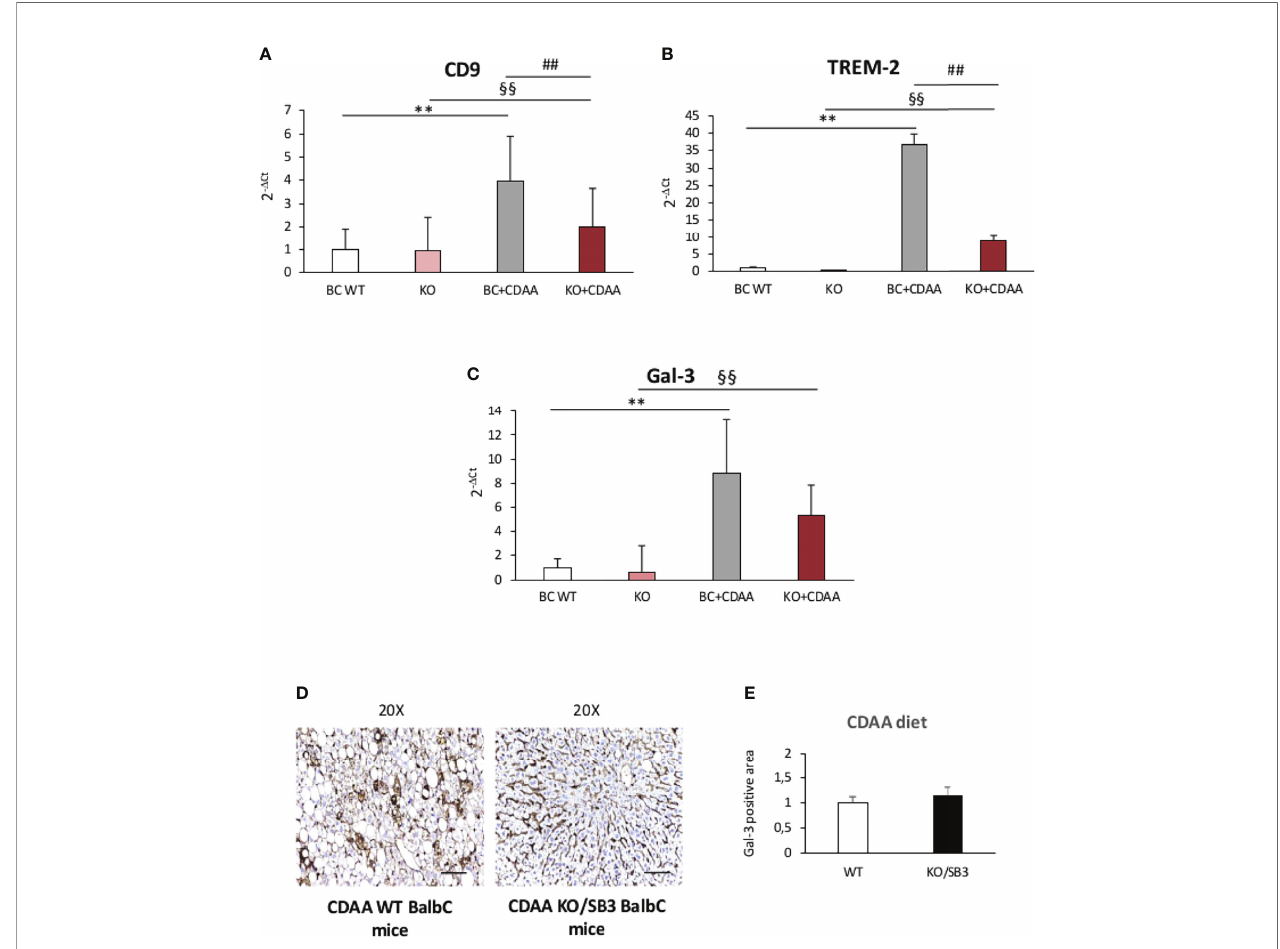
FIGURE 7 | (A – E) Quantitative real time PCR analysis of CD9, (A) TREM-2 (B) and Gal-3 (C) in control BalbC mice and knock out mice for SB3 fed on control diet (BC WT and KO) or CDAA diet for 12 weeks (BC+CDAA and KO+CDAA). **p < 0.01 versus BalbC control mice fed with control diet (BC WT); §§ p < 0.01 versus BalbC control mice fed with control diet (KO), ## p < 0.01 versus BalbC control mice fed with CDAA diet (BC+CDAA). (D) Immunohistochemistry analysis for Gal-3 in liver specimens obtained from WT BalbC mice and KO/SB3 BalbC mice fed on CDAA diet for 12 weeks. Magni fi cation 20x, scale bar 100µm. (E) ImageJ software analysis was performed to evaluate the amount of Gal-3 positive area in BalbC WT mice and knock out mice for SB3 (KO/SB3) fed on CDAA for 12